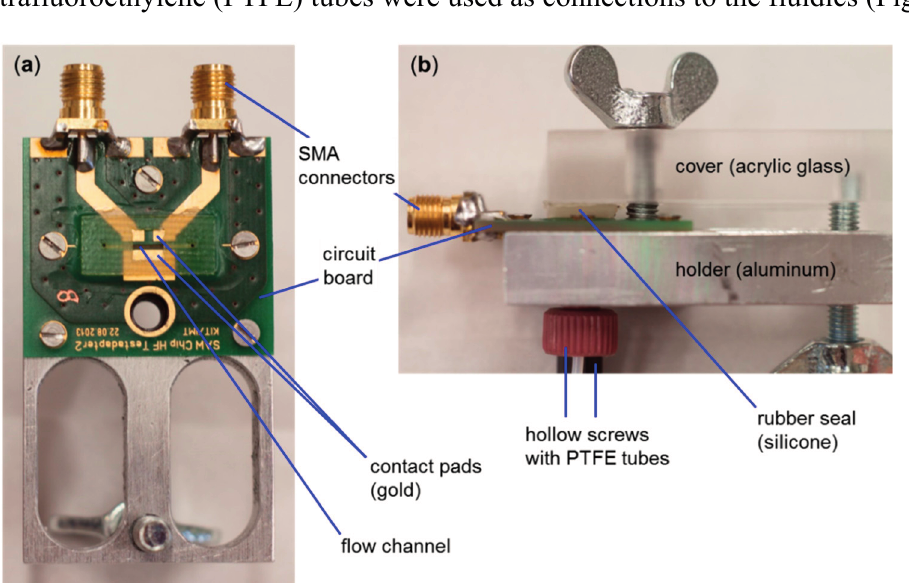
Figure 3. Flow cell connecting the SAW resonator to the driving electronics and the peripheral fluidic system. ( a ) Open flow cell (top view), without cover; ( b ) Flow cell closed with cover (side